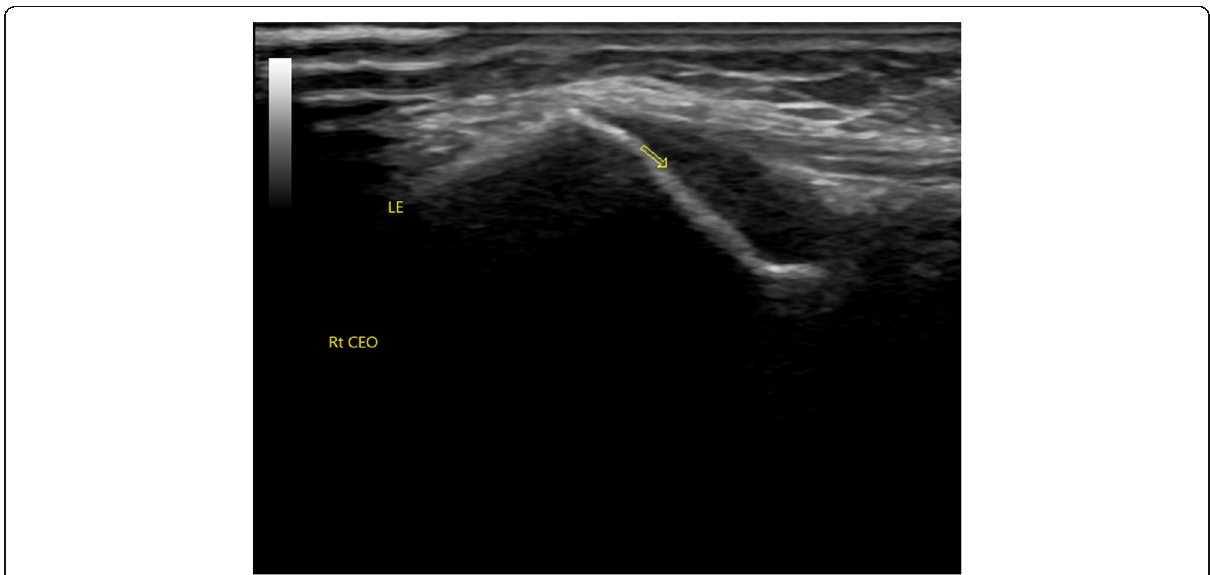
Fig. 4 US picture showing disturbed fibrillar pattern of Rt. CEO tendon of a patient before US treatment. LE, lateral epicondyle; RT, right common extensor